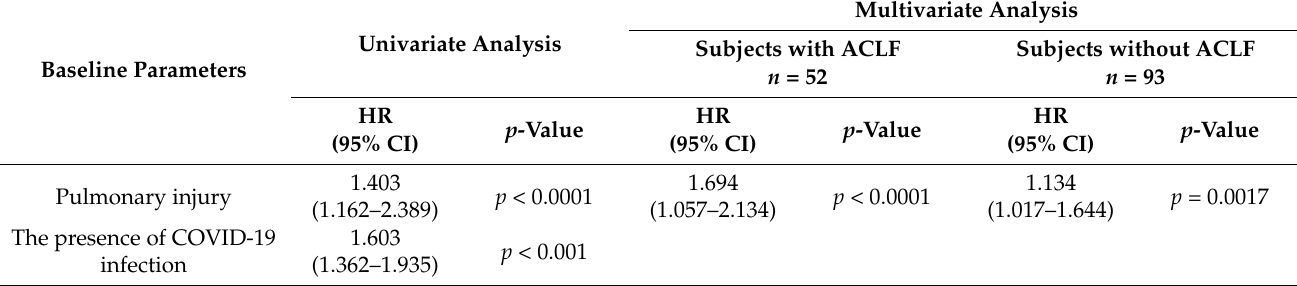
Table 4. Predictors of mortality during